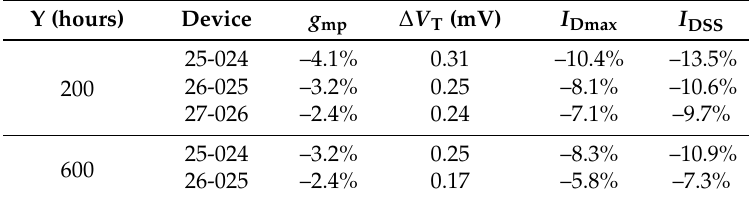
Table 4. Parameter changes by device and stress time in the 600-h test: g mp , V T , I Dmax , and I DSS